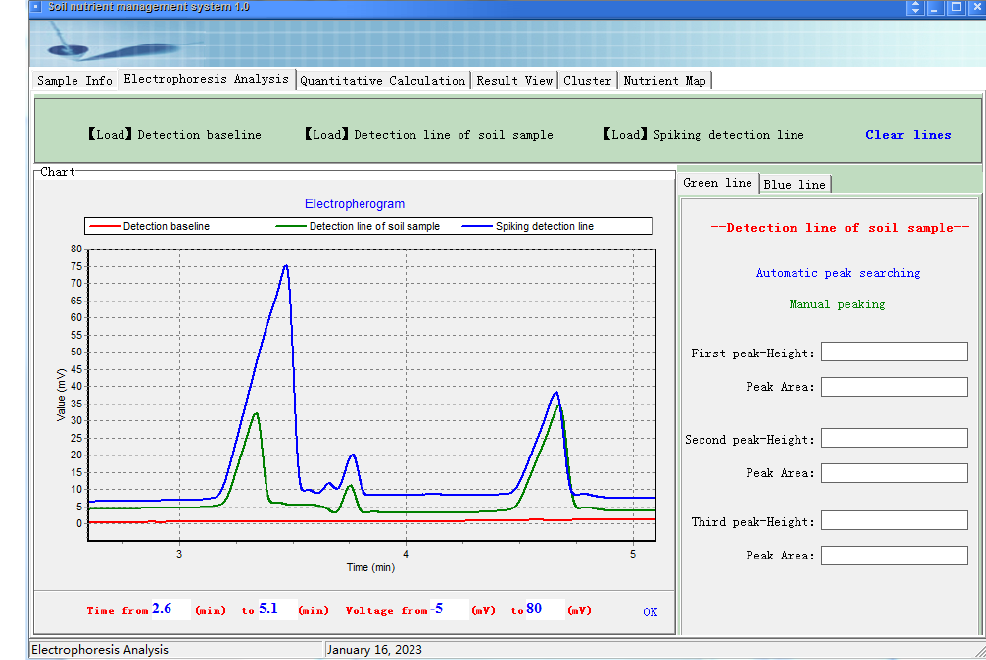
Figure 3. Electrophoretic peak for K + of Xuchang soil sample B 1 .